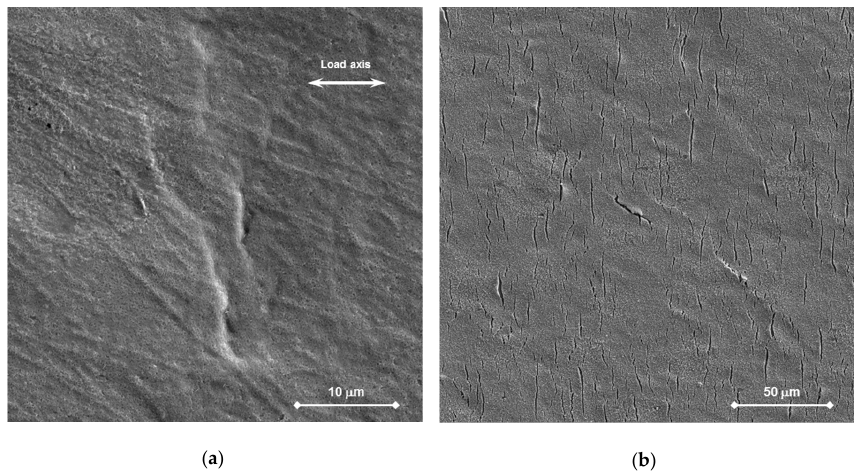
Figure 7. Tapered specimen after CERT by R1 test rate at 400 °C, observation of the polished surface: ( a ) In air, the site of maximum deformation in the minimum cross section showing a layer of oxides obscuring slip bands (T31); ( b ) In Pb and after chemical cleaning, the surface in the minimum cross section showing superficial cracks and indications of deformation below oxides (T37).